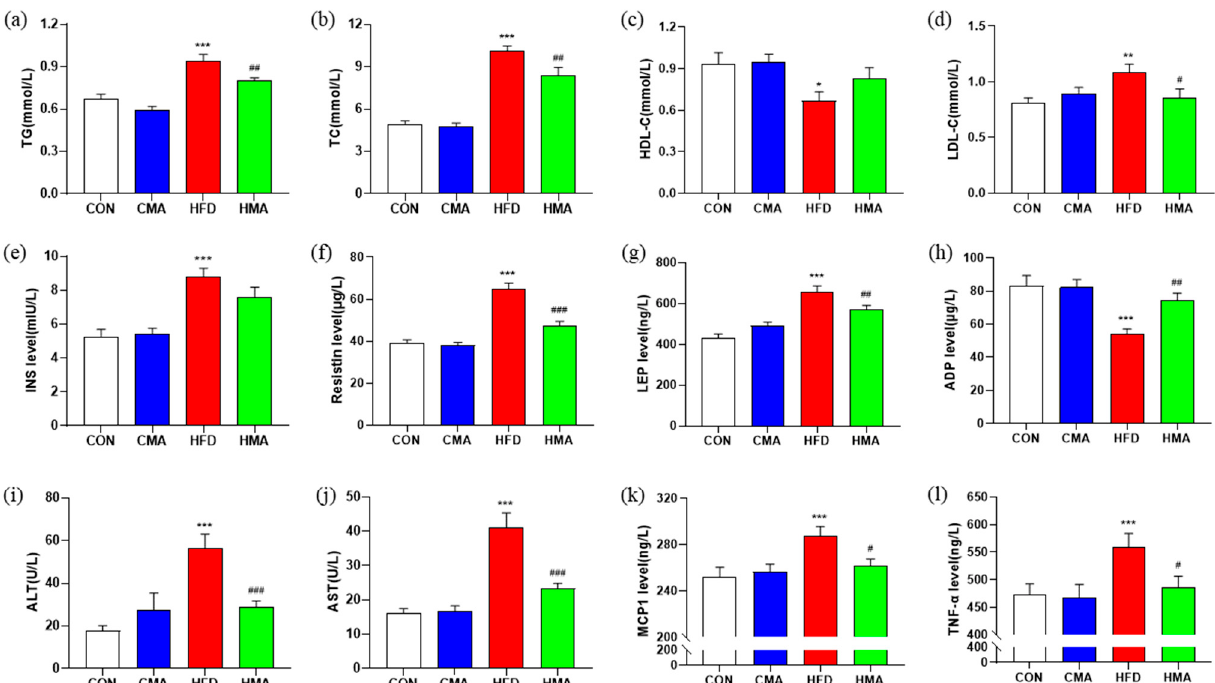
Figure 2. Effects of MA on serum lipid metabolism, liver function and inflammatory response in mice. ( a ) Serum TG. ( b ) Serum TC. ( c ) Serum HDL-C. ( d ) Serum LDL-C. ( e ) Serum INS content. ( f ) Serum resistin content. ( g ) Serum LEP content. ( h ) Serum ADP content. ( i ) Serum ALT activity. ( j ) Serum AST activity. ( k ) Serum MCP1 content. ( l ) Serum TNF- α content. Values are expressed as mean ± SEM (n = 10). Differences between the CON group and the CMA and HFD groups are indicated by *. *** p < 0.001, ** p < 0.01, * p < 0.05. Differences between the HFD and HMA groups are expressed by # . ### p < 0.001, ## p < 0.01, # p < 0.05.